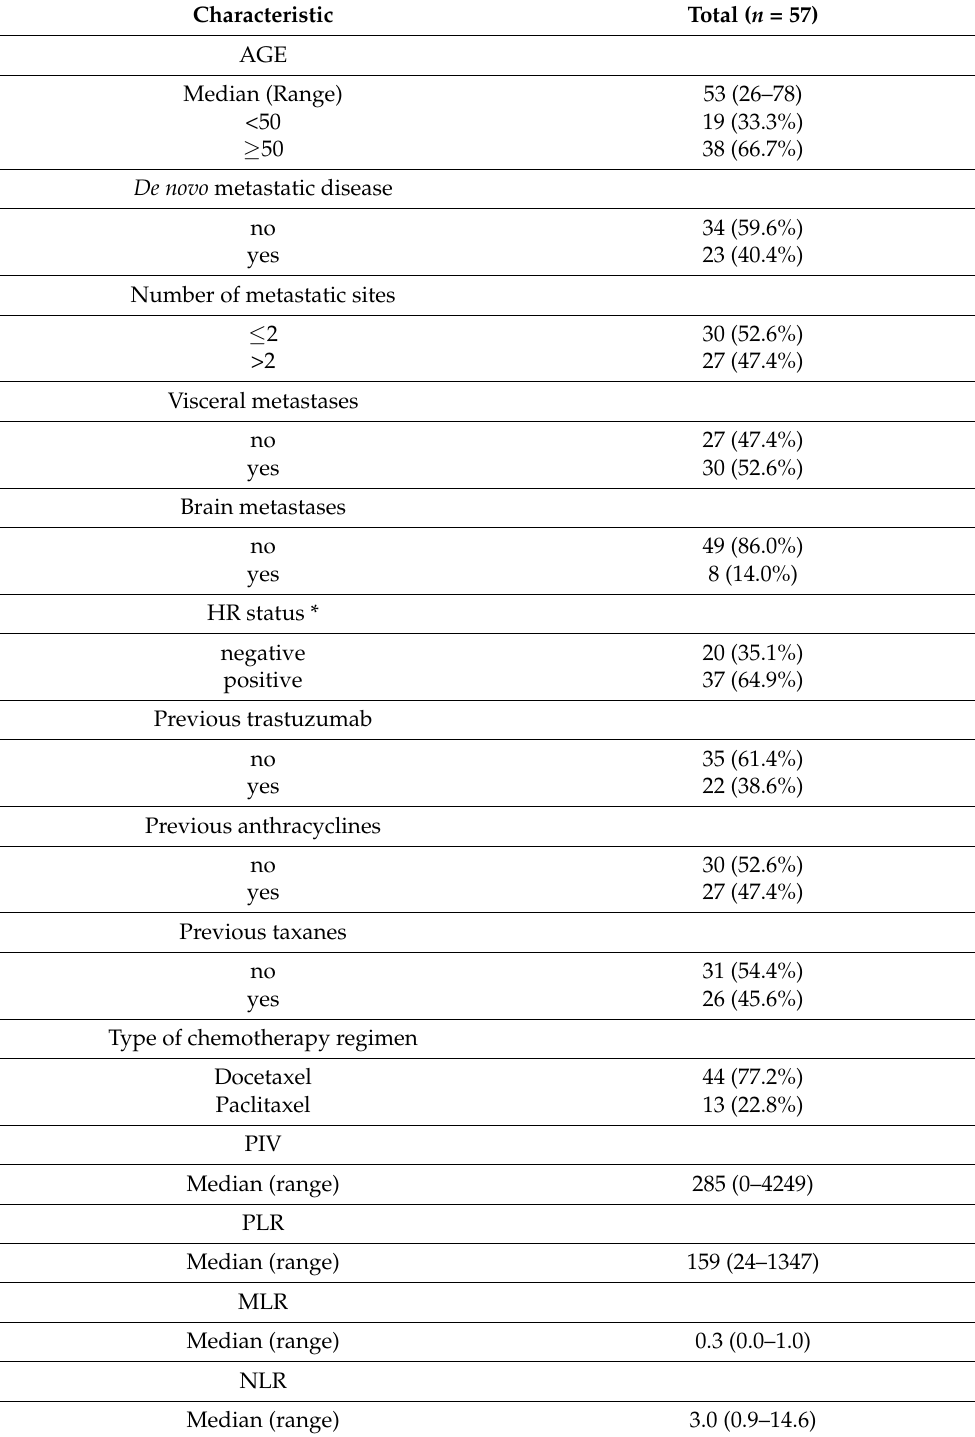
Table 1. Patient and disease